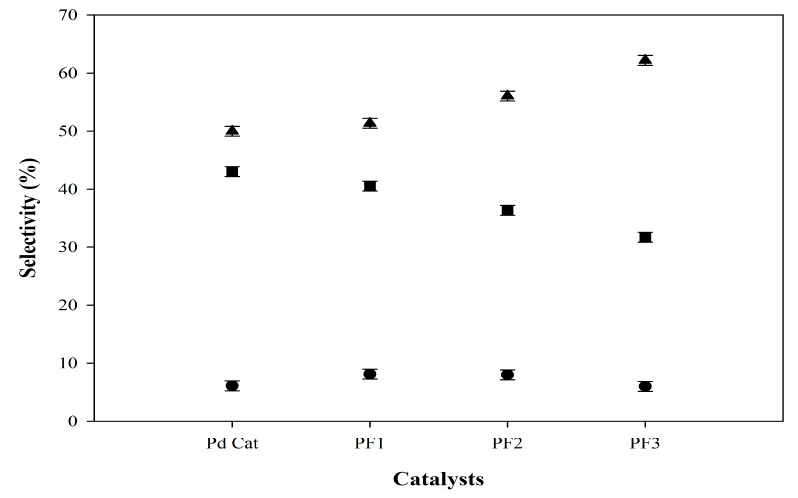
Figure 5. Percentage of selectivity in terms of green gasoline ( ● ), green kerosene ( ■ ), and green diesel ( ▲ ) as functions of different catalysts (Pd cat, PF1, PF2, PF3).